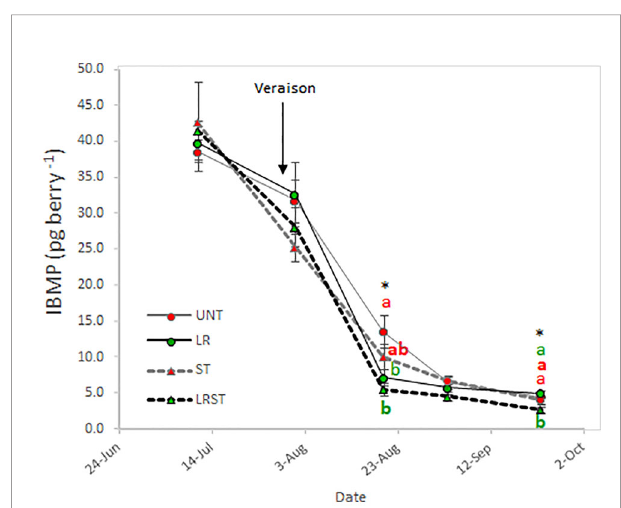
FIGURE 6 | Effect of canopy management practices (UNT: Untreated, LR: Leaf removal, ST: Shoot thinning and LRST: LR and ST combined) on berry IBMP content during the growing season. Values represent means ± SE (n = 4). At each time point, different letters indicate signi fi cant differences ( p < 0.05) between canopy management practices according to the one-way ANOVA followed by Duncan's new multiple range test. * indicate signi fi cance at 5% probability